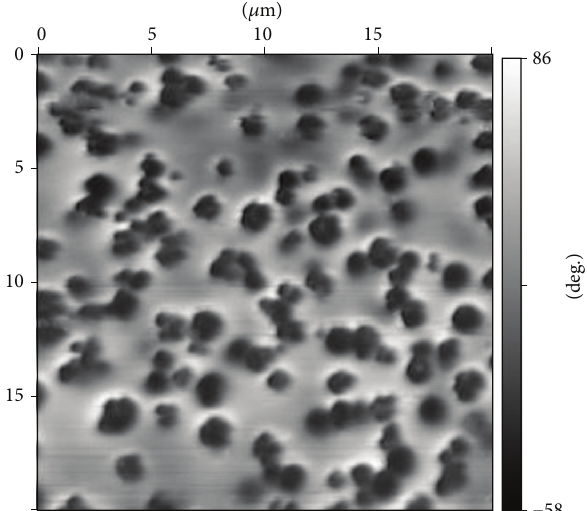
Figure 4: MFM image of the Fe25 glass surface at 4.2 K and at 𝐻 = 4000 Oe. The scanned region - 20 × 20 𝜇 m 2 . Scale (in degrees) on the right value of phase at measurement of magnetic response in MFM